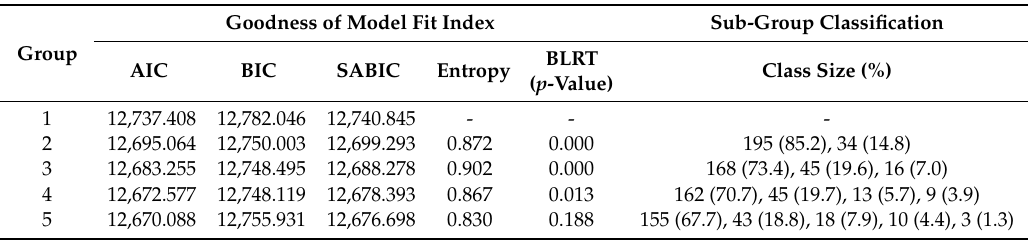
Table 3. Growth Mixture Model Fitness.